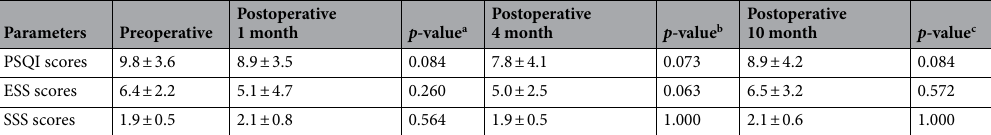
Table 3. Pre- and post-operative sleep disturbance scores in the patients who underwent total thyroidectomy followed by 131 I treatment. Values are express as mean ± SD. PSQI Pittsburgh sleep quality index, ESS Epworth sleepiness scale, SSS Stanford sleepiness scale. a p -values from the Mann–Whitney U test between preoperative and postoperative 1 month. b p -values from the Mann–Whitney U test between preoperative and postoperative 4 month. c p -values from the Mann–Whitney U test between preoperative and postoperative 10 month.